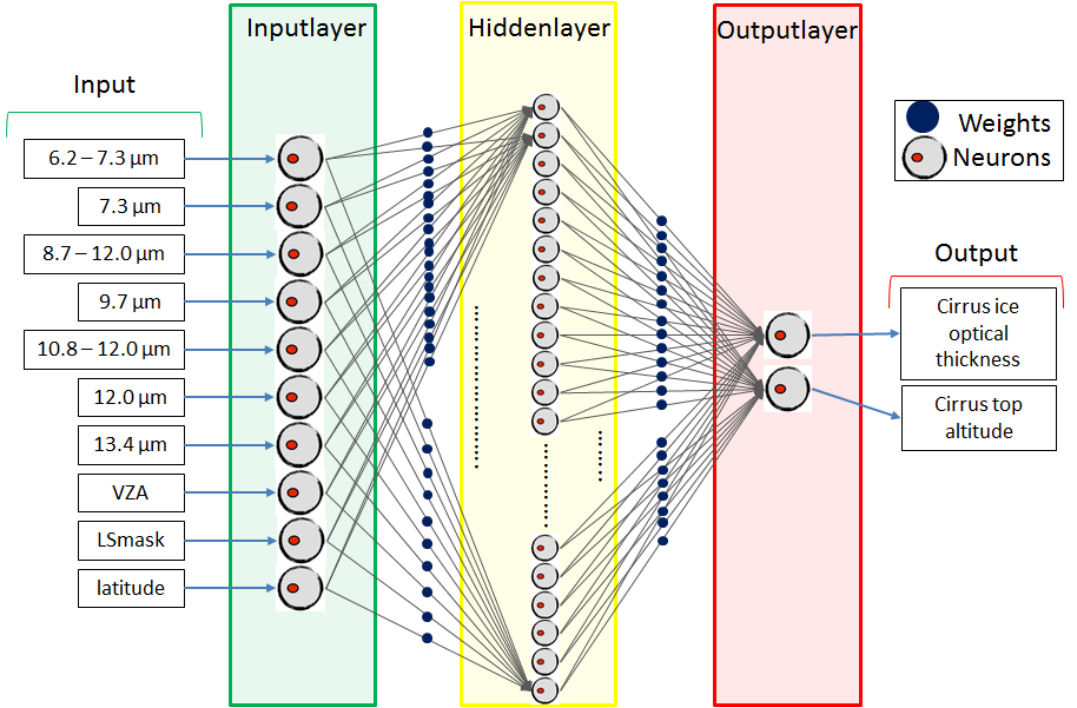
Figure 1. Scheme of the general setup of the backpropagation neural network for COCS and its input and output data sets. The different layers of the neural networks are shaded green, yellow and red for the input-, the hidden-, and the output layer respectively. The connections between each of the neurons of one layer to each neuron of the next layer are sketched by arrows, while the weight of each connection is stylized by a blue dot. The different inputs of COCS are shown on the left, the outputs on the